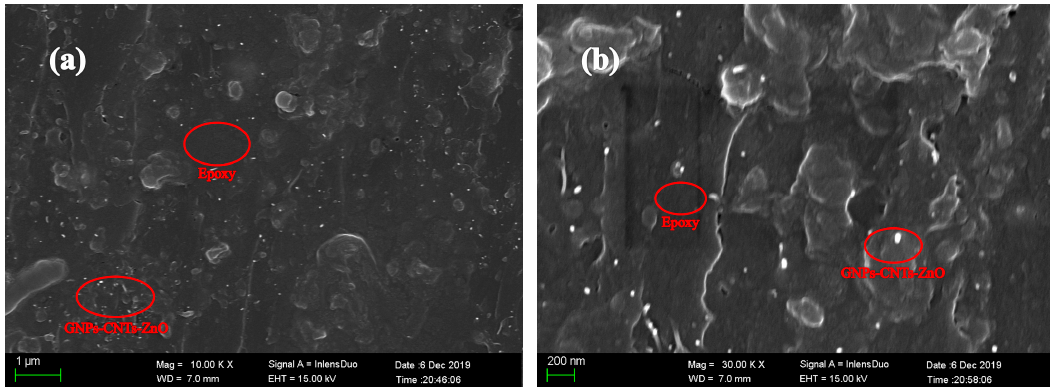
Figure 8. SEM image ( a ) and high magnification SEM ( b ) of the fracture surface of GNPs-CNTs-ZnO/epoxy resin (ER) composite.